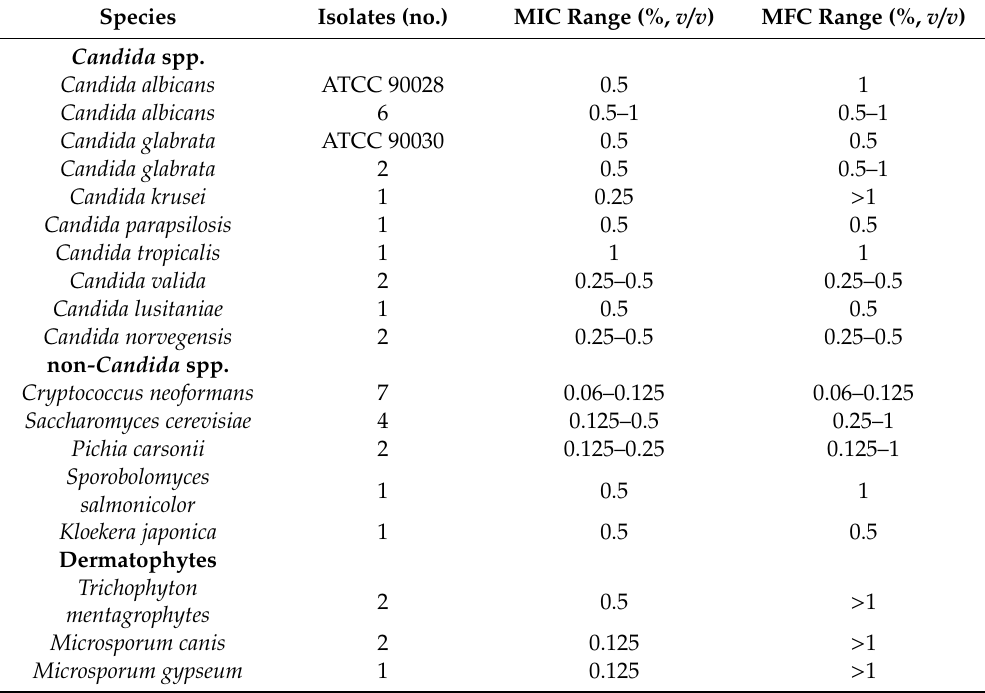
Table 2. MIC 1 and MFC 2 ranges of “Mentha of Pancalieri” essential oil towards yeasts and dermatophytes from clinical and ATCC strains.